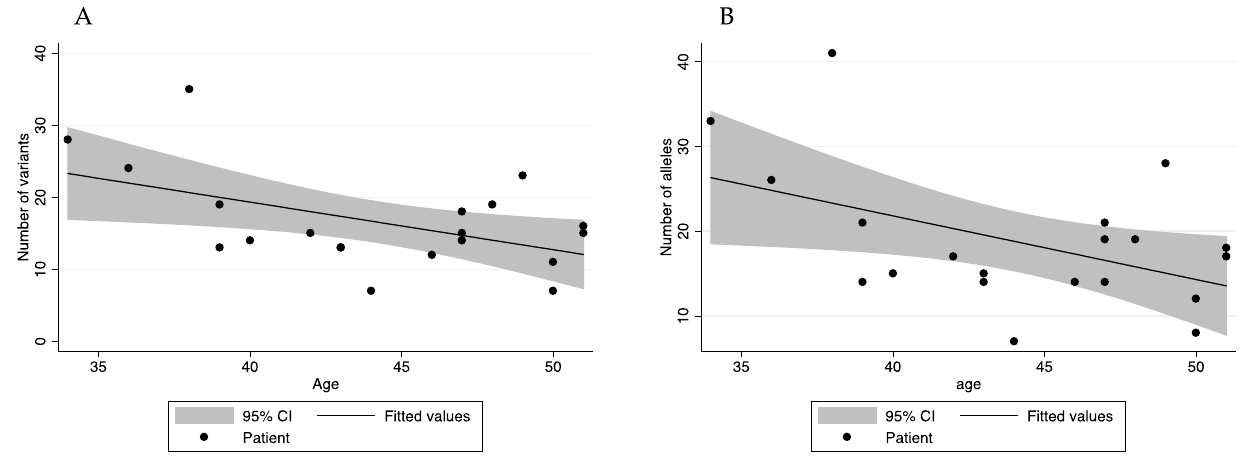
Figure 1. Relationship between number of candidate variants/alleles and age. Scatter plots depicting the significant trend between number of ( A ) risk variants ( p = 0.021) and ( B ) risk alleles ( p = 0.033) and age in the discovery cohort. Figure was created using Stata v11 (StataCorp—www. stata.